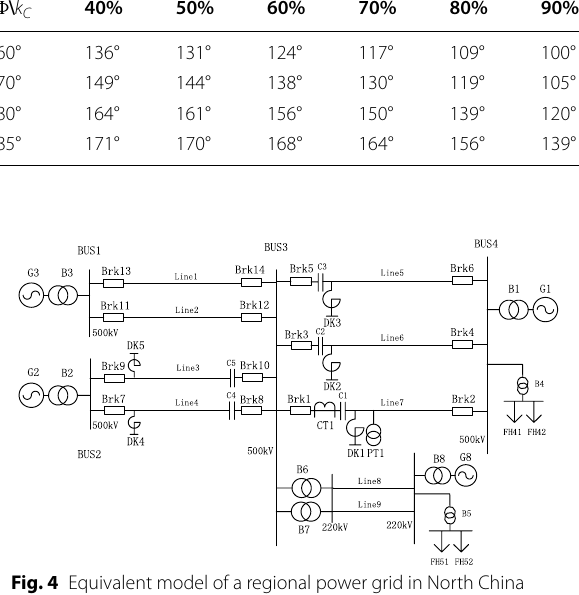
Fig. 4 Equivalent model of a regional power grid in North China